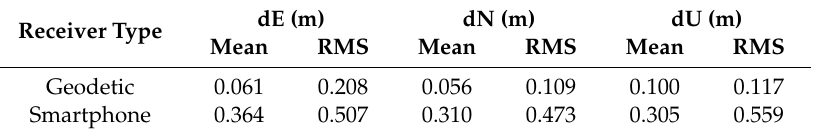
Table 3. Mean and RMS for East, North, and Up